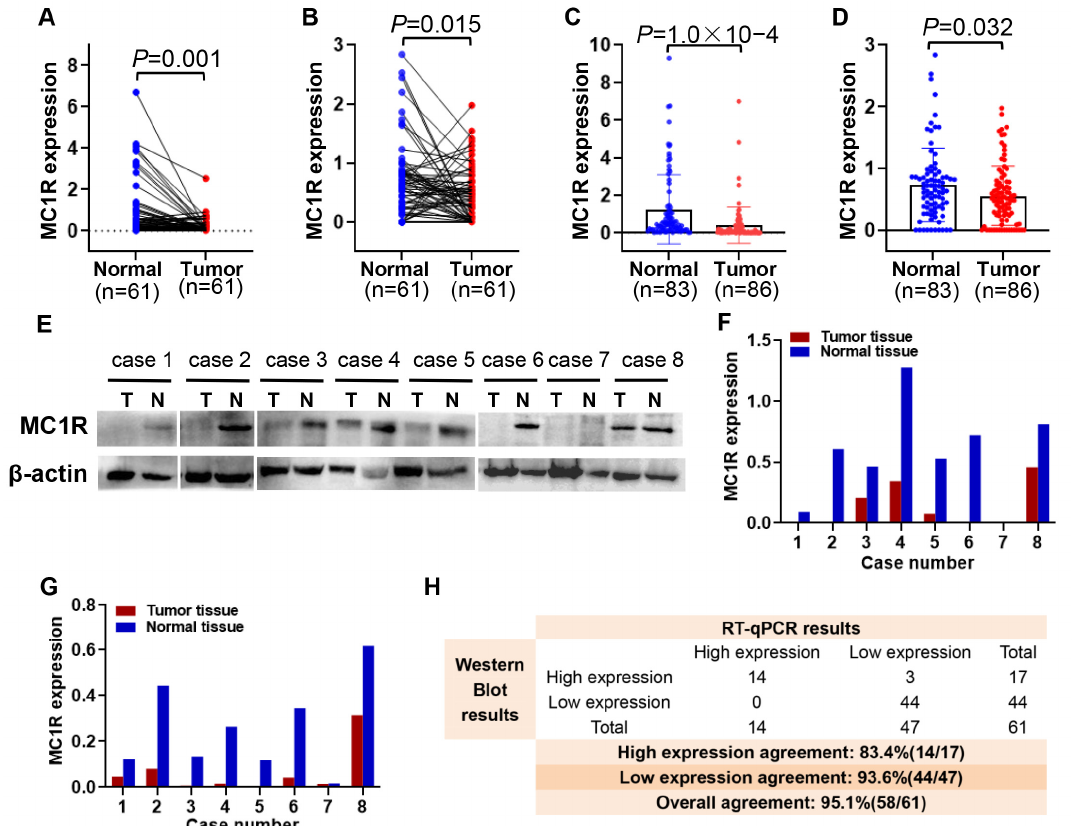
Figure 3. MC1R expression in CRC clinical tumor samples. MC1R expression in 61 CRC tumor samples and paired normal tissue samples ( A ) Detected by RT-qPCR ( B ) Detected by Western blotting. MC1R expression in 92 CRC tumor samples and 85 normal tissue samples. ( C ) Detected by RT-qPCR ( D ) Detected by Western blotting. MC1R expression in 8 representative cases that belong to the results of 61 paired CRC and adjacent normal tissues. ( E ) and ( F ) Detected by Western blotting ( G ) Detected by RT-qPCR. ( H ) Consistency analysis for detecting MC1R by RT-qPCR and Western blotting in tissue